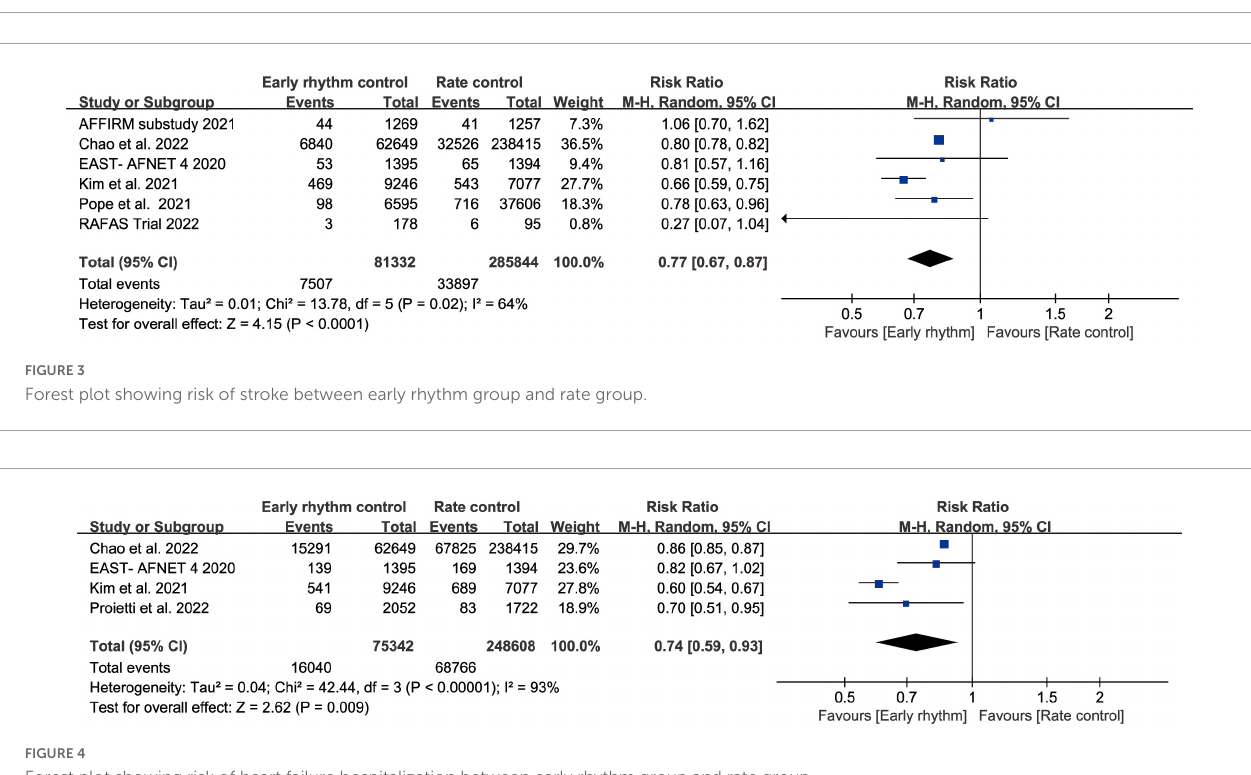
compared to rate control, early rhythm control appears to be related to lower all-cause mortality, cardiovascular mortality, stroke, and HF hospitalization. Nevertheless, there was no difference between